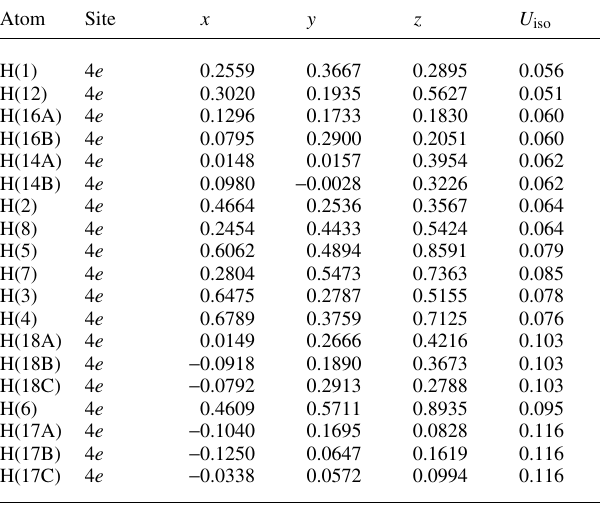
Table 2. Atomic coordinates and displacement parameters (in Å 2 )